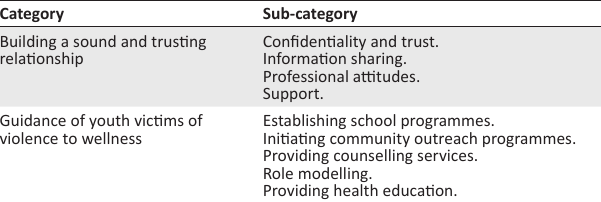
TABLE 2: Expectations of the youth victims of